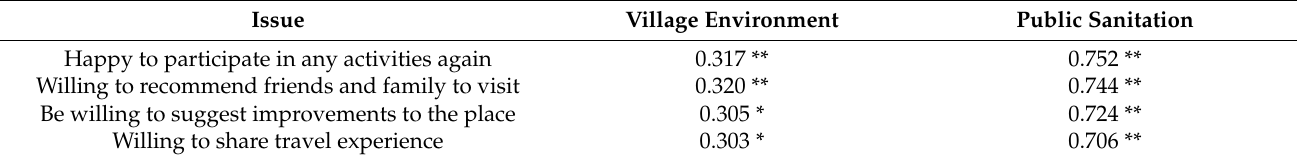
Table 9. Correlation analysis of the environmental impact and re-tourism